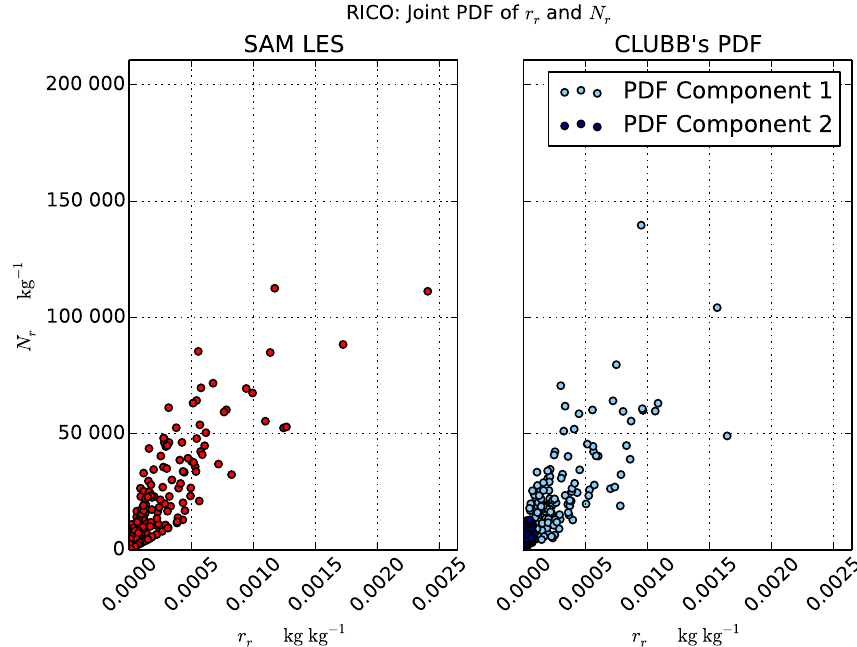
Figure 3. Joint PDF of r r and N r in the RICO precipitating shallow cumulus case at an altitude of 380m and a time of 4200min. SAM LES results are the red scatter points. CLUBB PDF scatter points were generated by sampling the DDL PDF using an unweighted Monte Carlo scheme. The SAM LES domain is 256 × 256 grid points. So to provide for the best comparison of LES points to CLUBB PDF sample points, 65536 CLUBB PDF sample points were used. The light blue scatter points are from PDF component 1 and the dark blue scatter points are from PDF component 2. Every 10th point was plotted from both SAM LES and CLUBB’s PDF. The joint nature of the PDF allows r r and N r to correlate the same way in CLUBB as they do in